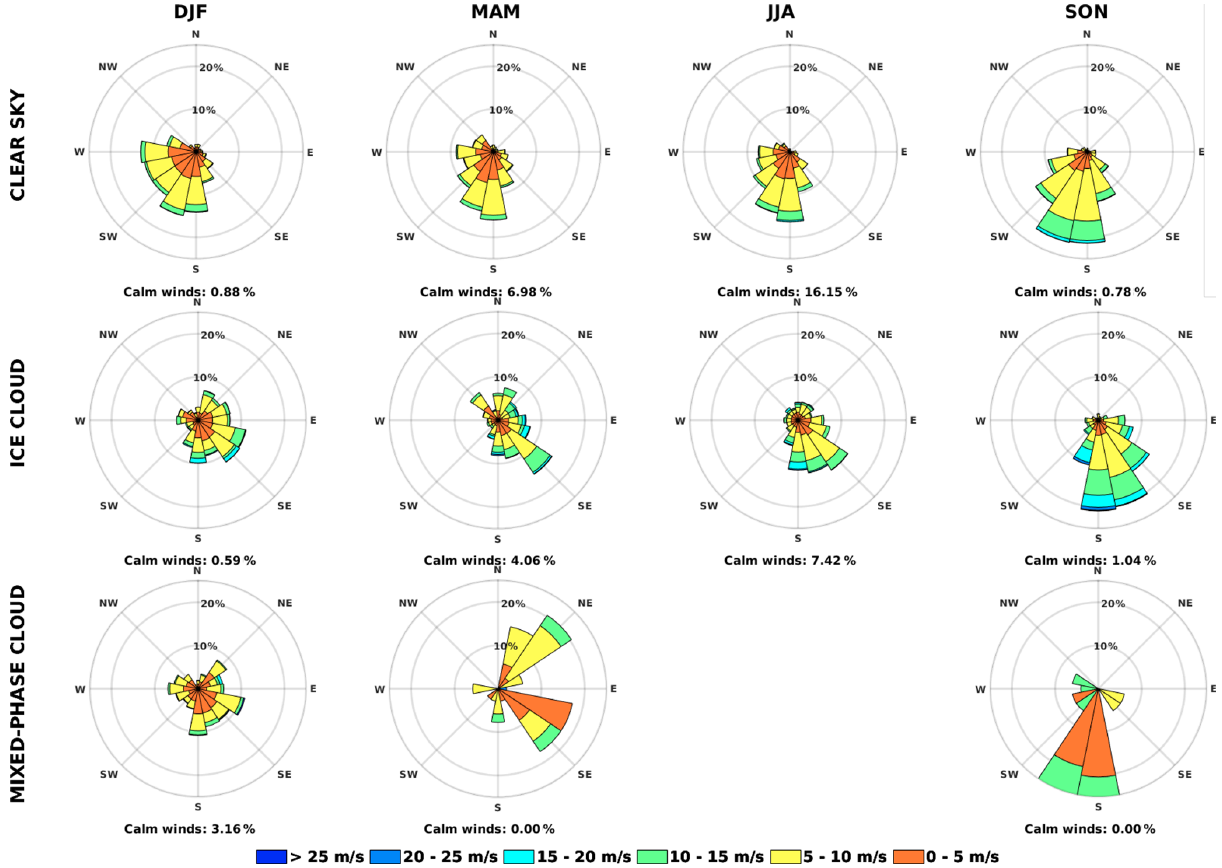
Figure 9. Wind roses at Concordia Station for the four seasons (DJF, MAM, JJA, and SON) of the period 2012–2015. Clear-sky, ice cloud, and mixed-phase cloud conditions are split into separate rows.